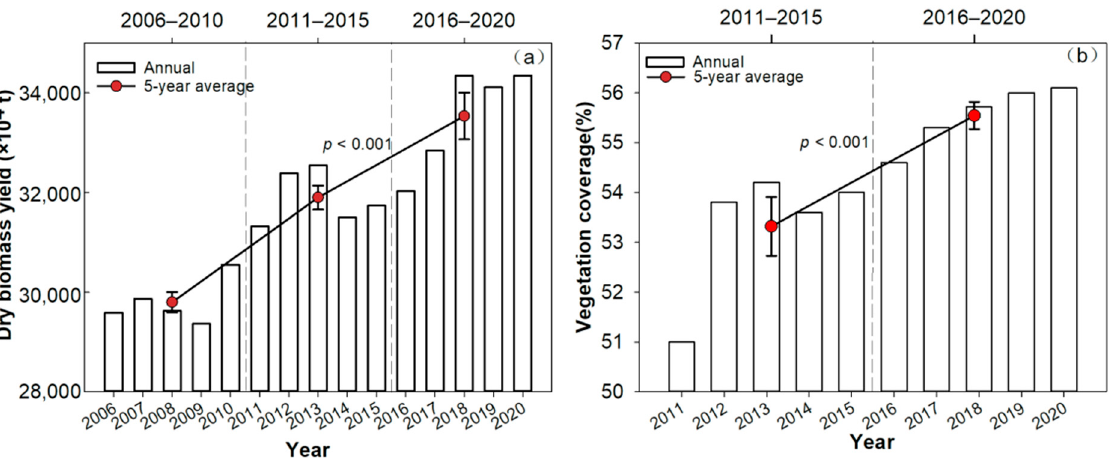
Figure 1. Trends in natural grassland hay yield ( a ) and vegetation coverage ( b ) in China from 2006 to 2020.